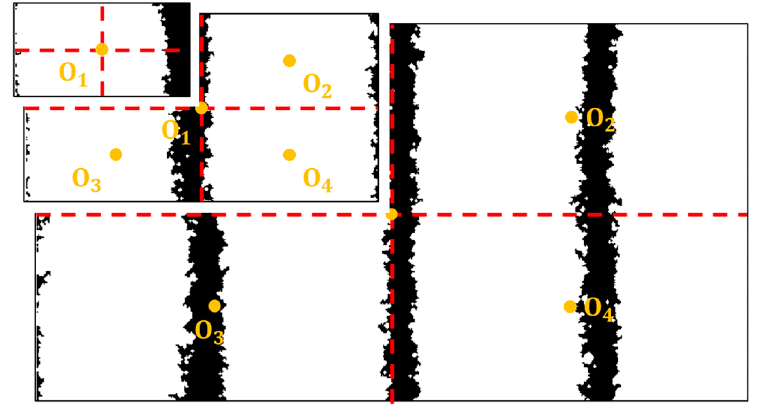
Figure 16. The process of measurement locations alignment.